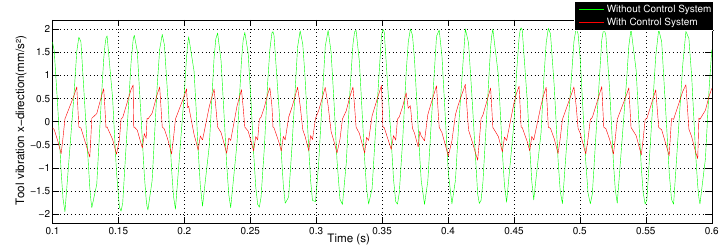
Figure 10. Tool vibration along x -direction using DSMC-T2 fuzzy.